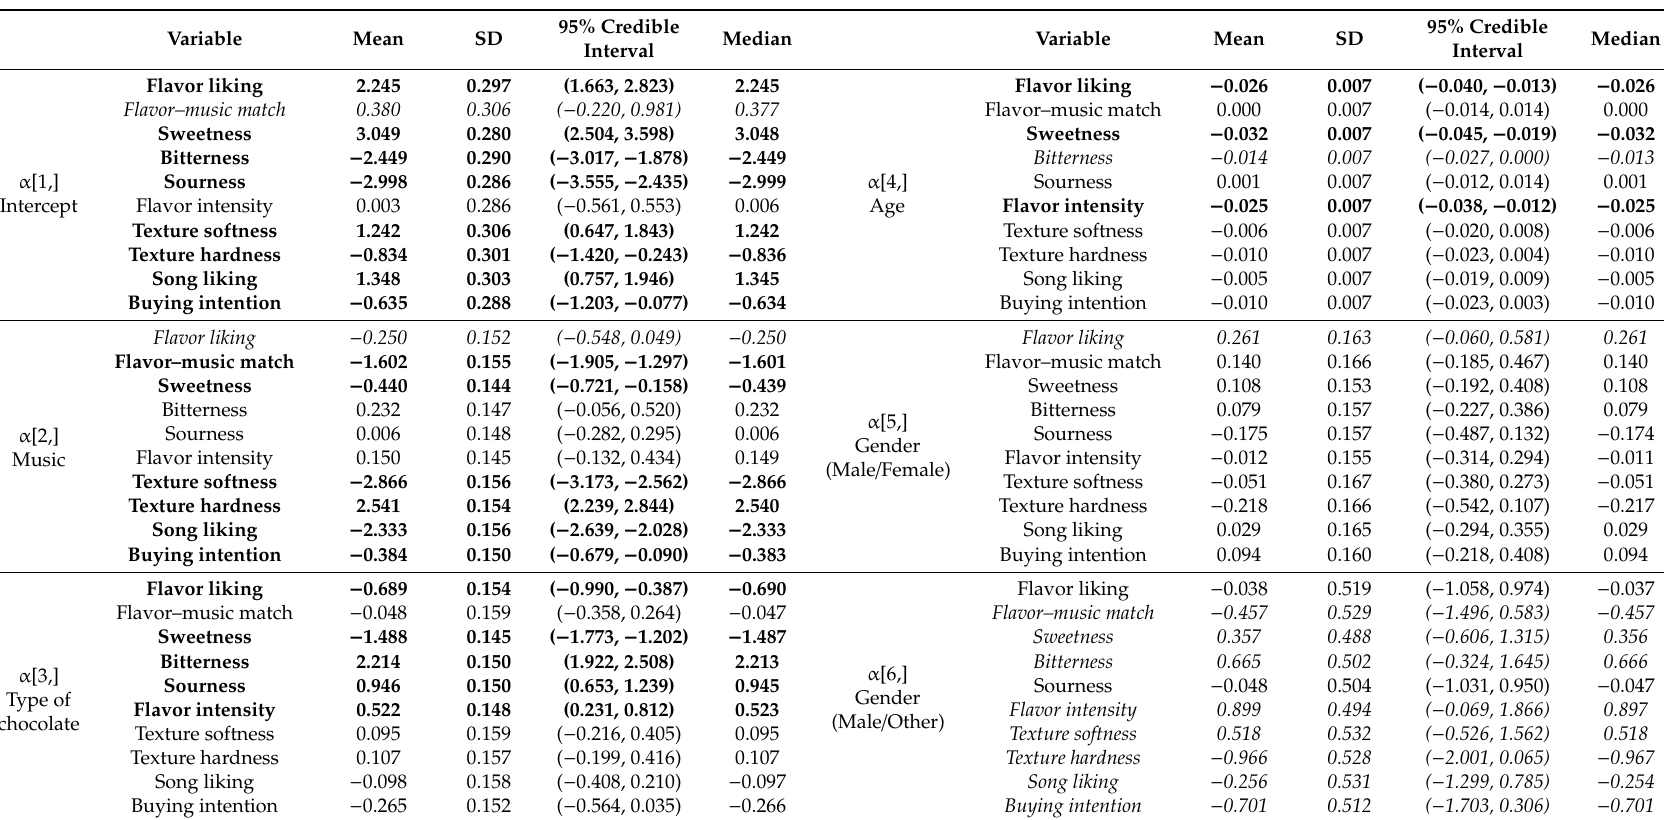
Table 4. Posterior means, posterior standard deviations, 95% credible intervals, and posterior medians for all parameters in the Bayesian logit-normal emotional music regression model. Values highlighted in bold represent stronger evidence of associations. Values in italics constitute weaker evidence of associations. All other values represent no evidence of